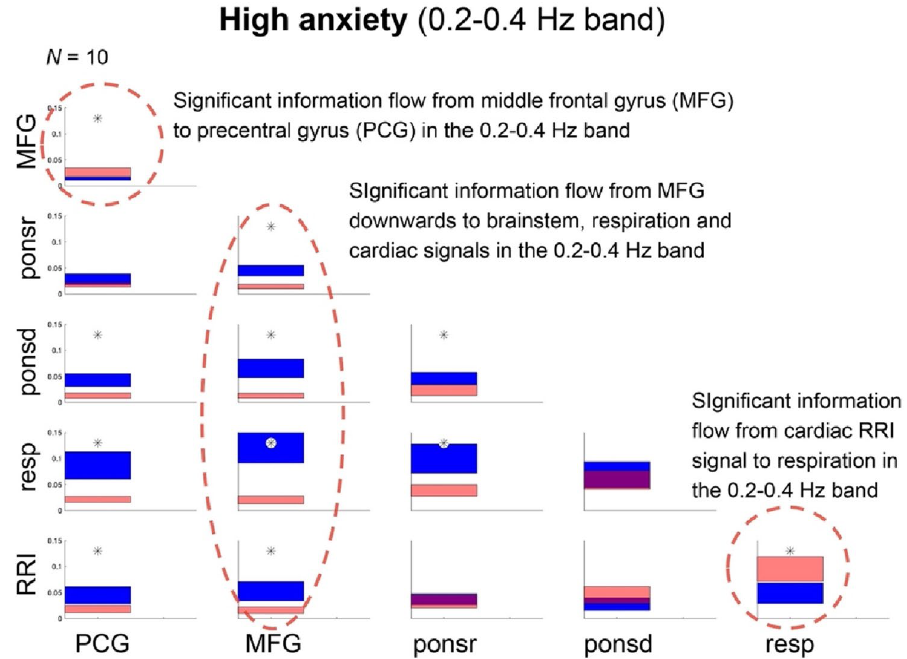
Figure 1. Directed coupling strengths for the high anxiety group in the 0.2–0.4 Hz frequency band. Each box shows the strength of coupling on the vertical scale. The height of bars is proportional to the mean error. The blue color shows the flow from the signal marked below the given column to the signal marked at the left, and the red color the flow from the signal marked at left to the signal marked below. Significant differences between couplings of inflow and outflow are marked by stars ( p < 0.05). Note the highly-significant flow from the middle frontal gyrus (MFG, ROI 7) to the brainstem (ROIs 93 and 103), respiration and RRI (marked by a stippled ellipse), and the significant flow from the MFG to the precentral gyrus (PCG, ROI 1) and the significant flow from RRI to respiration (marked by a stippled circles).